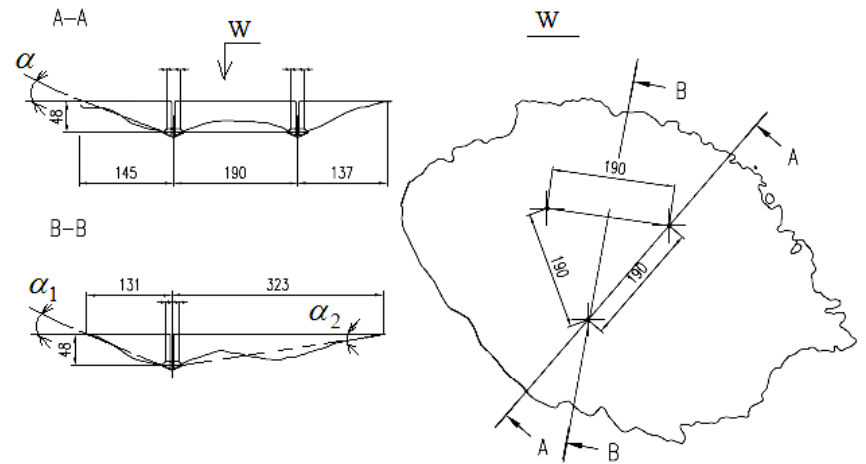
Figure 15. An outline of the failure surface on the free surface of the rock material and cross-sections of a break-out prism pulled out by the 3-anchor anchorage system.